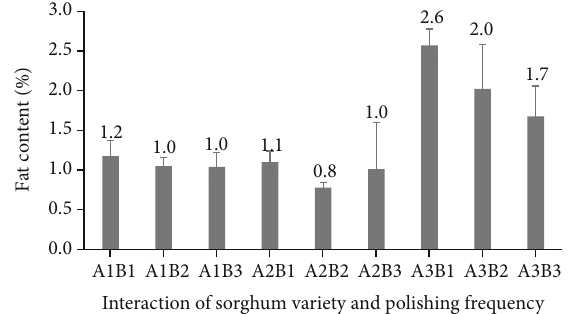
Figure 10: Fat content of three varieties of polished sorghum grains at di ff erent polishing frequencies.